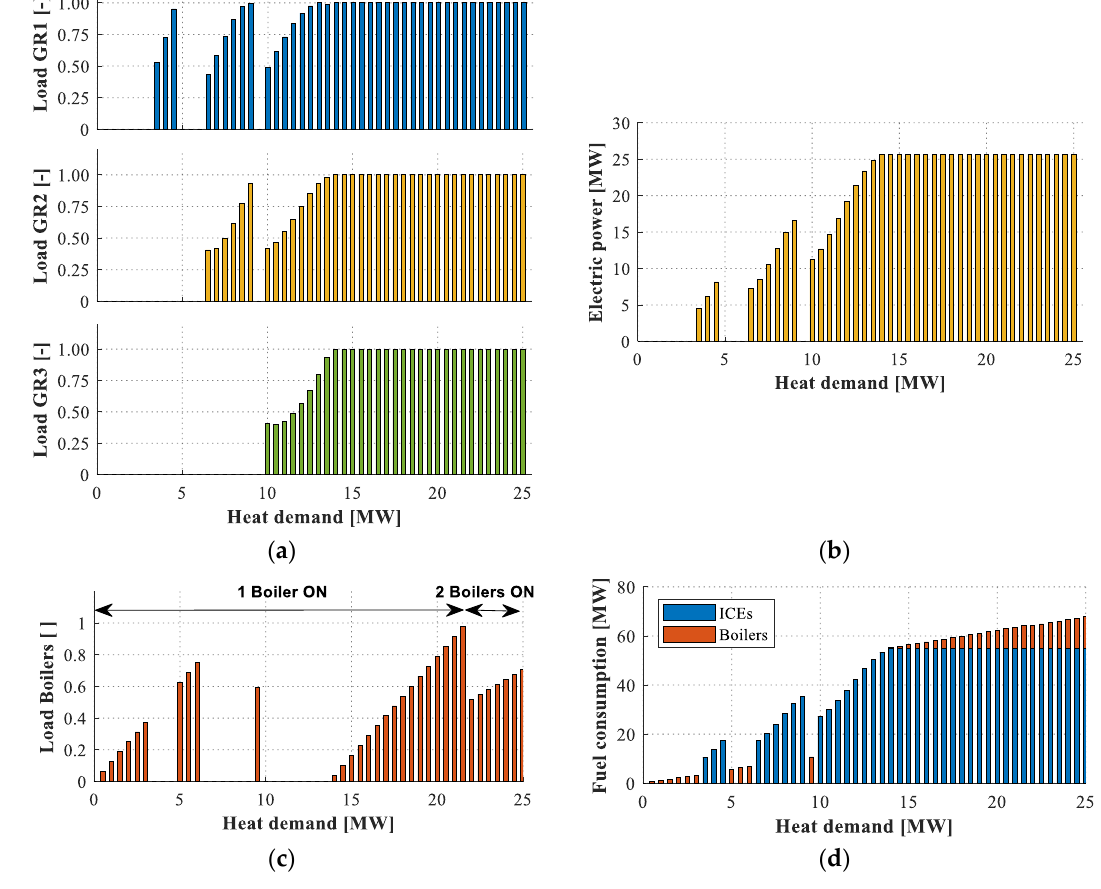
Figure 4. Combined heat and power (CHP) system output loads and fuel consumption as a function of the district heating (DH) heat demand: ( a ) load of the ICE units; ( b ) CHP unit total electric power output; ( c ) boilers load as a function of the heat demand; ( d ) total natural gas consumption.